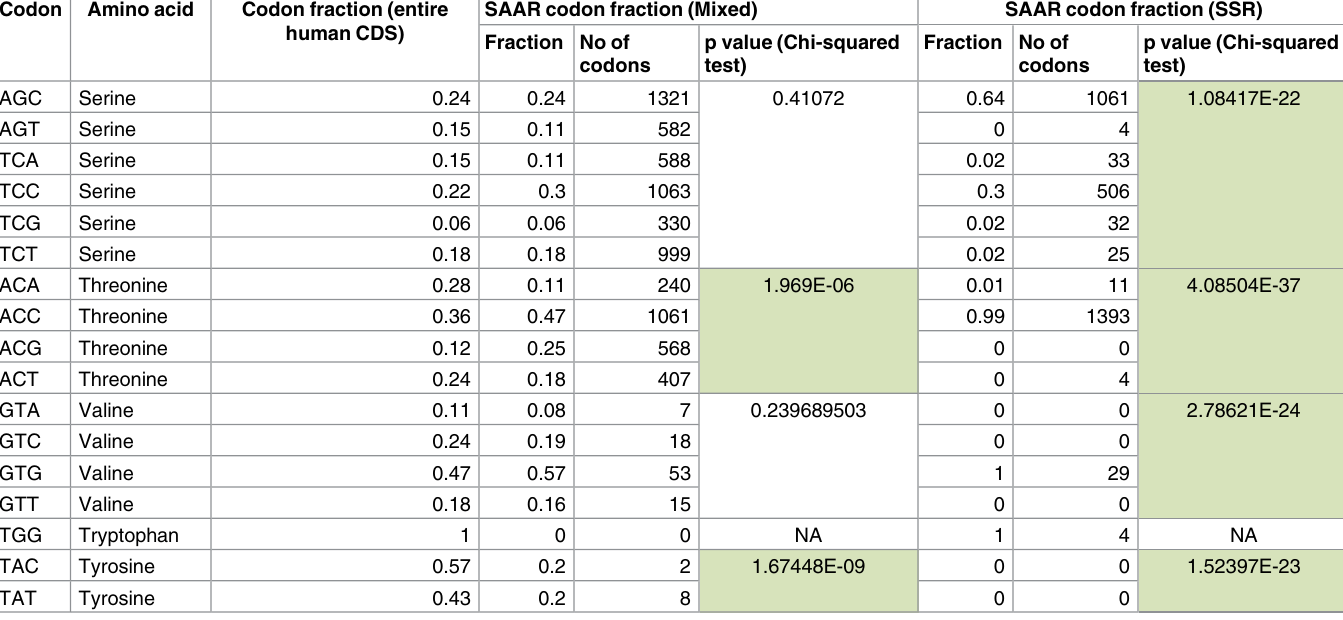
(88% GAT) and glycine (84% GGC). The bias shown by these amino acids was statistically sig- nificant (p < 0.0001, Chi-squared test, Table